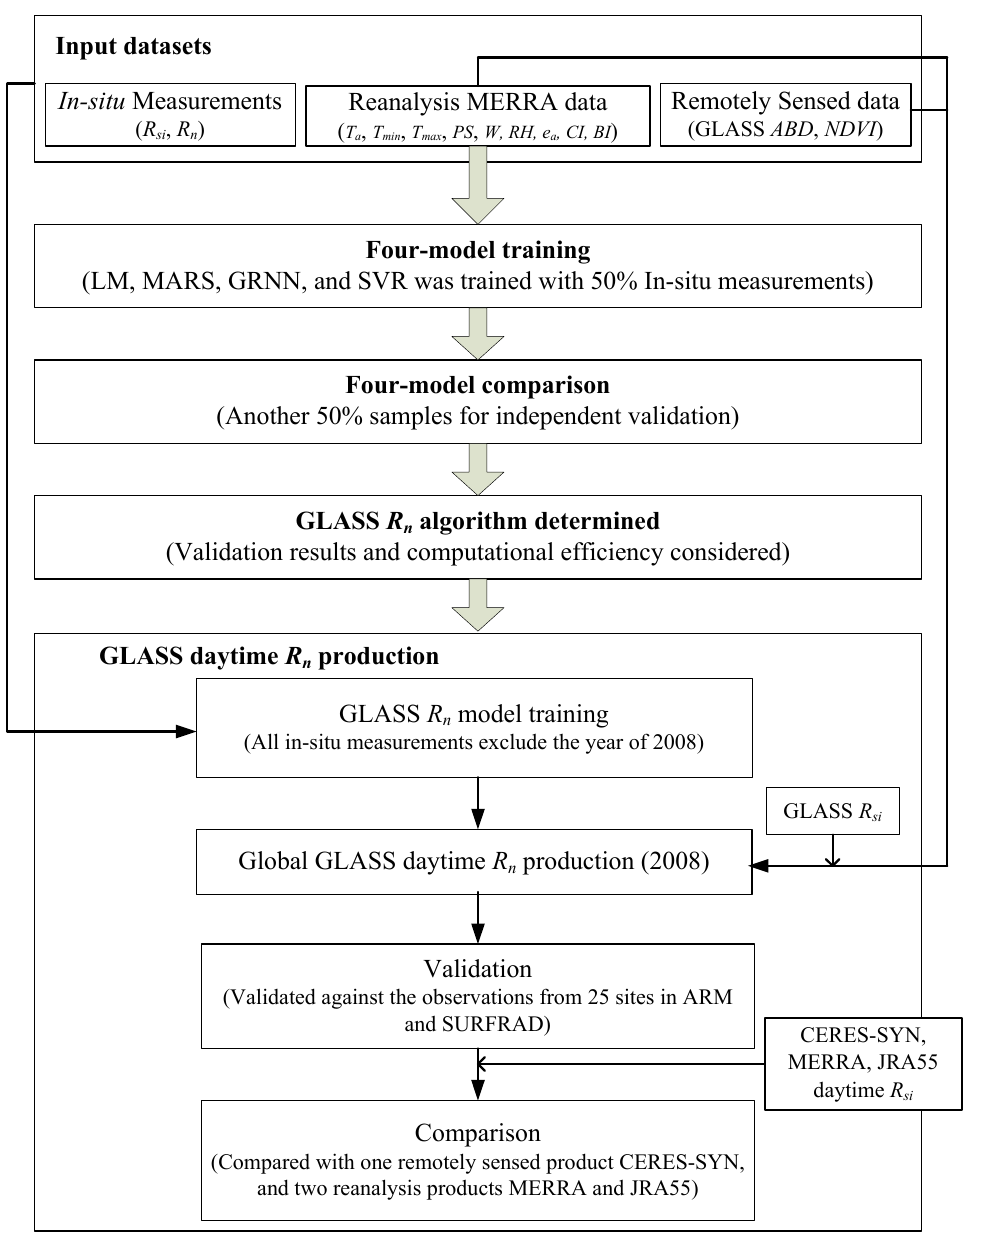
Figure 2. Flowchart of this study, the explanations of the variables are given in Table 2.